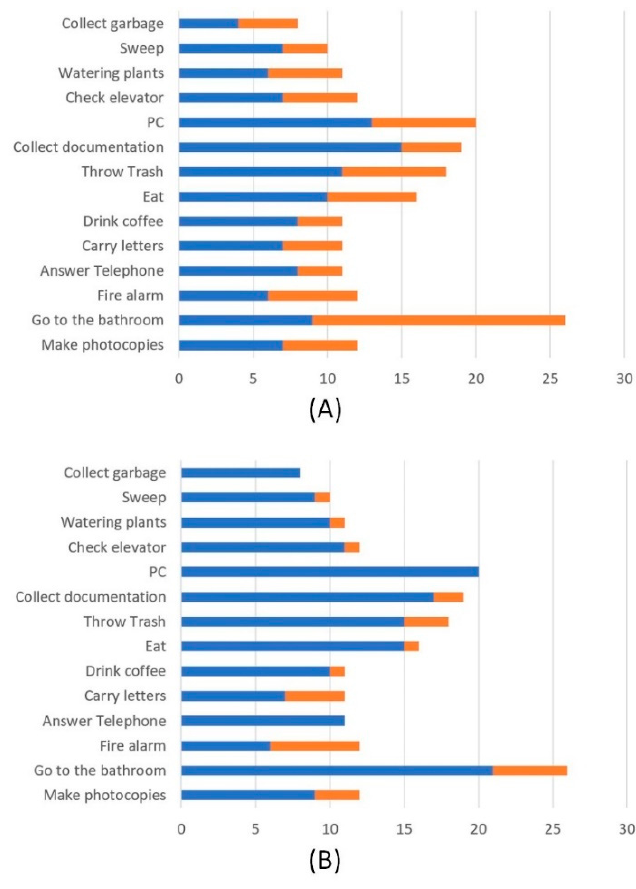
Figure 11. Successful and failed tasks after simulations. ( A ) results after first simulation; ( B ) results after second simulation.